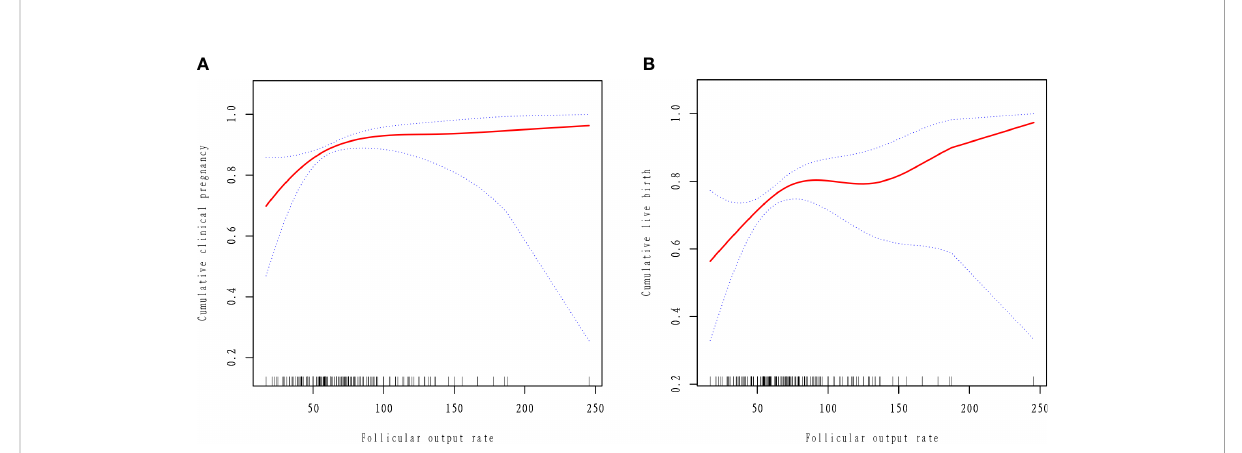
FIGURE 2 Curve fi tting between follicular output rate and clinical outcomes. The adjusted smoothed plots between the follicular output rate with the cumulative clinical pregnancy rate and the cumulative live birth rate based on two-piece-wise regression model (A, B) . The nonlinear relationship between the follicular output rate and the cumulative clinical pregnancy rate and the cumulative live birth rate, respectively. Adjustment factors included age, BMI, AMH, years of infertility, type of PCOS, treatment plan. The solid line and dashed line represent the estimated values and their corresponding 95% con fi dence intervals.